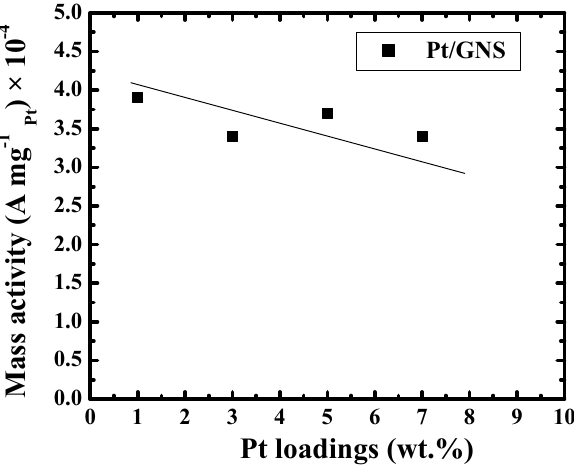
Figure 10. Graph mass activity vs Pt loading on GNS (wt.%) (CV